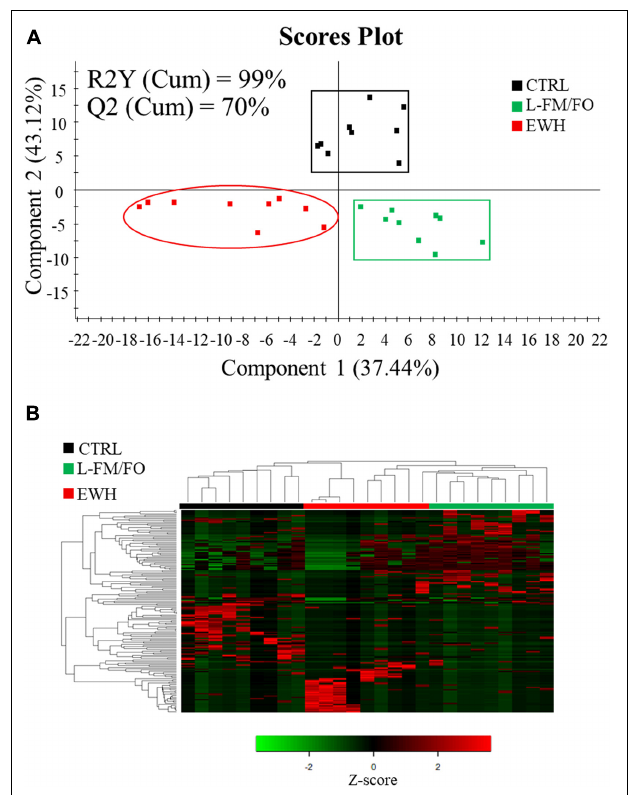
FIGURE 5 | (A) Two-dimensional PLS-DA scores plot constructed using the variable diet. The validation by the permutation test can be found in Supplementary Figure 2 . (B) Heatmap representing the abundance distribution ( Z -score) of the OTUs identified to be driving the separation by diet among all dietary